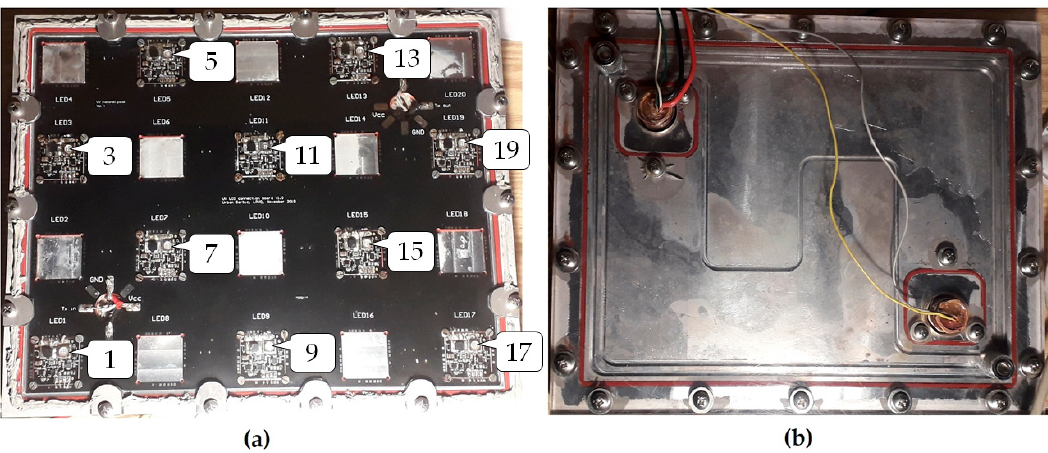
Figure 6. Prototype of the light source with 10 drivers and LEDs. ( a ) Light source front side, showing LED numbering and positioning used in this manuscript. ( b ) Light source back side.